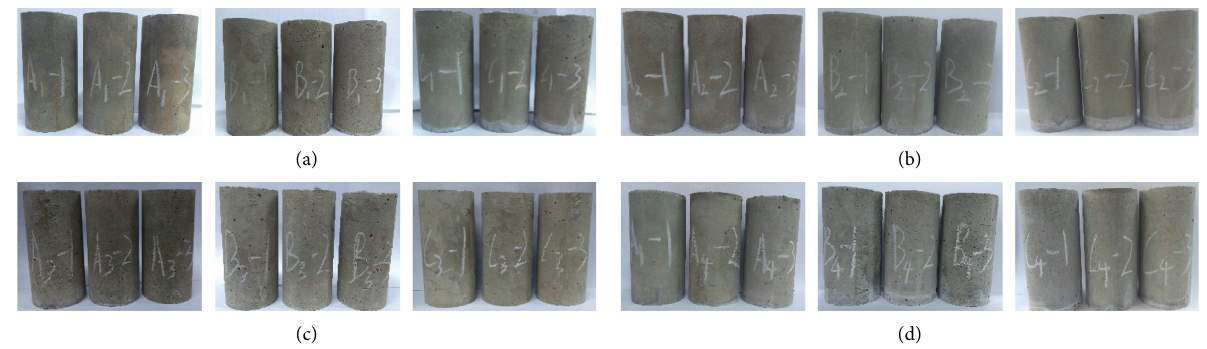
Figure 3: Colloid cement paste sample. (a) 7d age sample. (b) 14d age sample. (c) 21 d age sample. (d) 28d age sample.